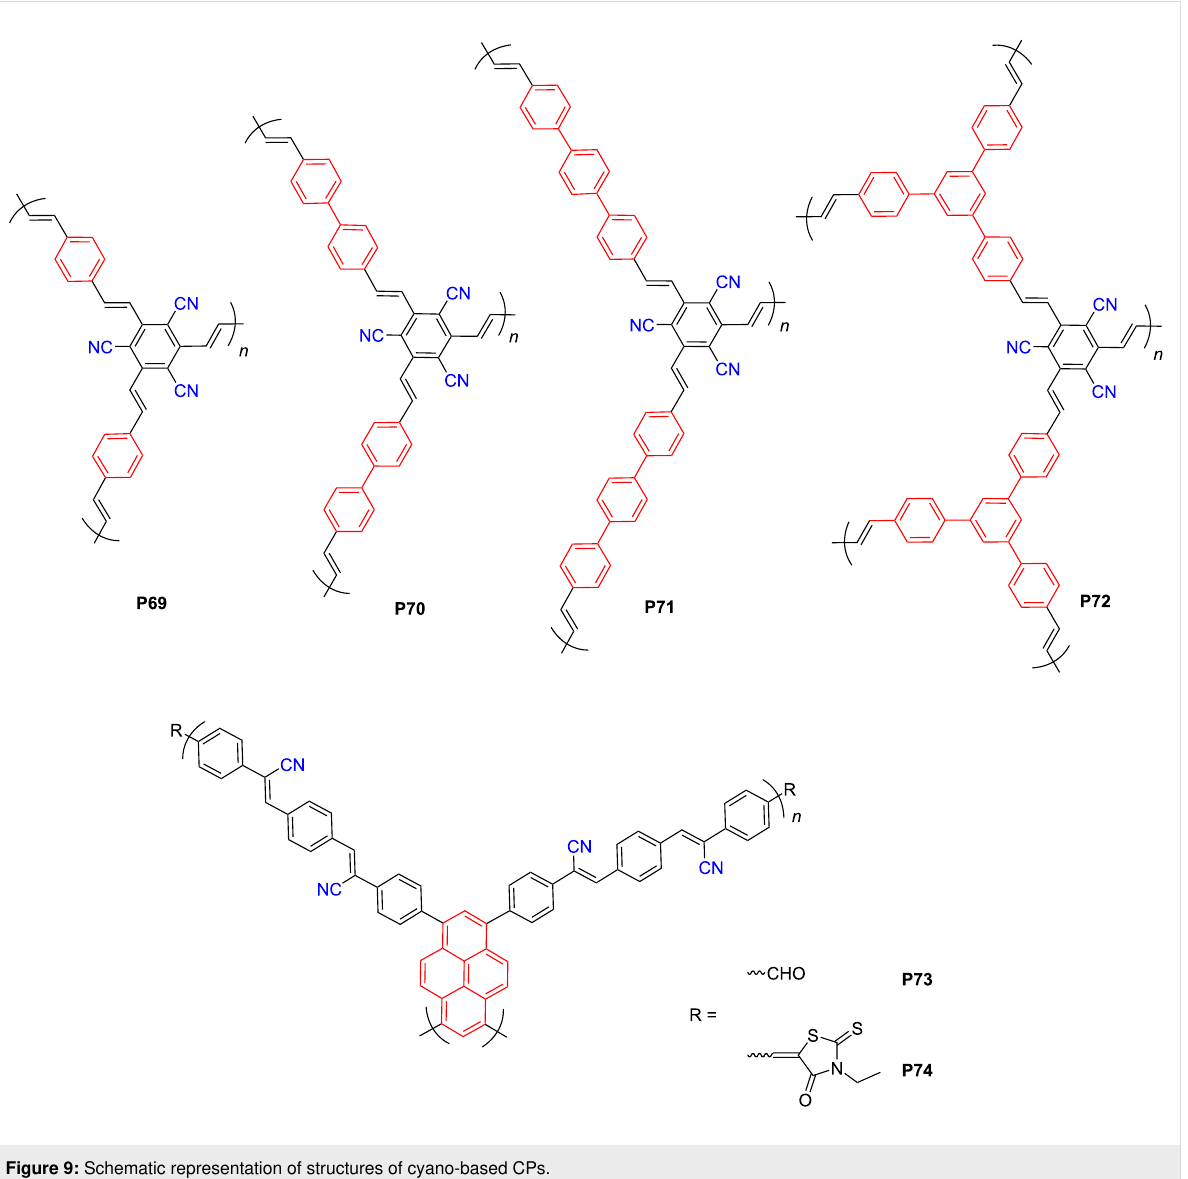
[95]. Due to the formation of abundant donor–acceptor inter- faces, P78 / P79 (Figure 10) exhibited the highest HER of 191.82 μ mol·h − 1 (1.15 mg) [95]. Recently, McCulloch and co-workers discovered another D/A heterojunction ( P80 / P81 ) (Figure 10) as photocatalyst for hydrogen evolution. By stabilizing the surfactant employed during synthesis of the heterojunction, ITIC-containing P80 as the acceptor could inti- mately blend with the donor P81 , which rendered HERs up to 128.85 μ mol·h − 1 (2 mg) [96]. Regarding heterojunctions with TiO 2 , for instance, Hua et al. used two indeno[1,2- b ]thiophene-based organic dyes ( P82 and P83 ) (Figure 10) to sensitize TiO 2 to harvest near-infrared